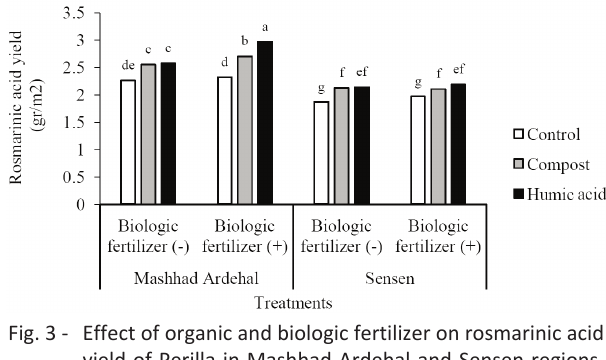
Fig. 3 - Effect of organic and biologic fertilizer on rosmarinic acid yield of Perilla in Mashhad Ardehal and Sensen regions. Different letters in each column denote a significant dif- ference at p≤0.05 (LSD